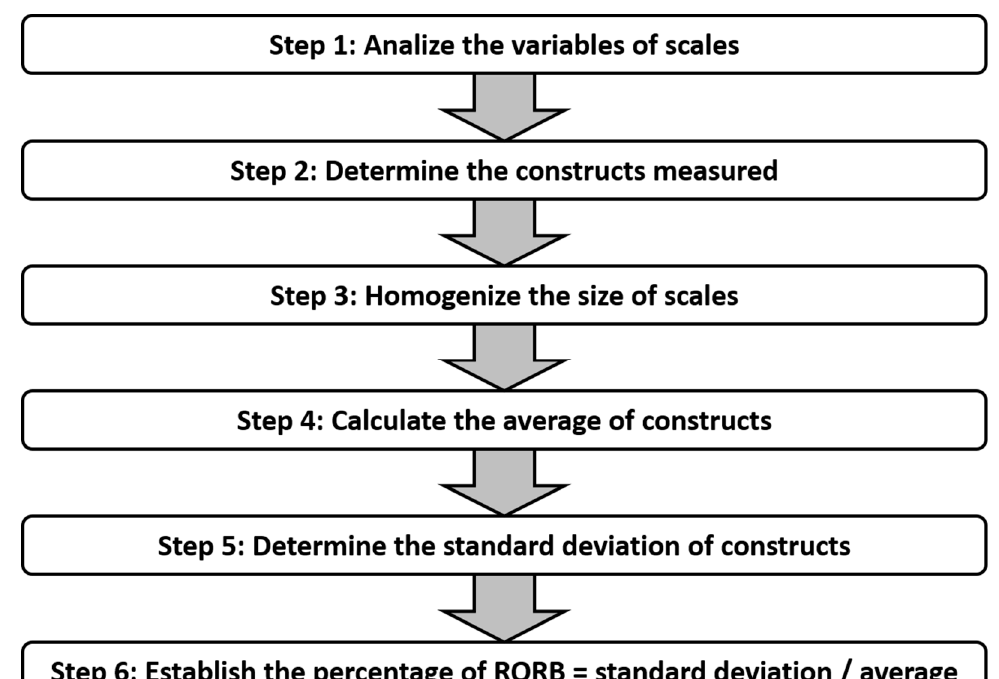
Figure 1. Methodology to determine the rating of the online reputation balance.